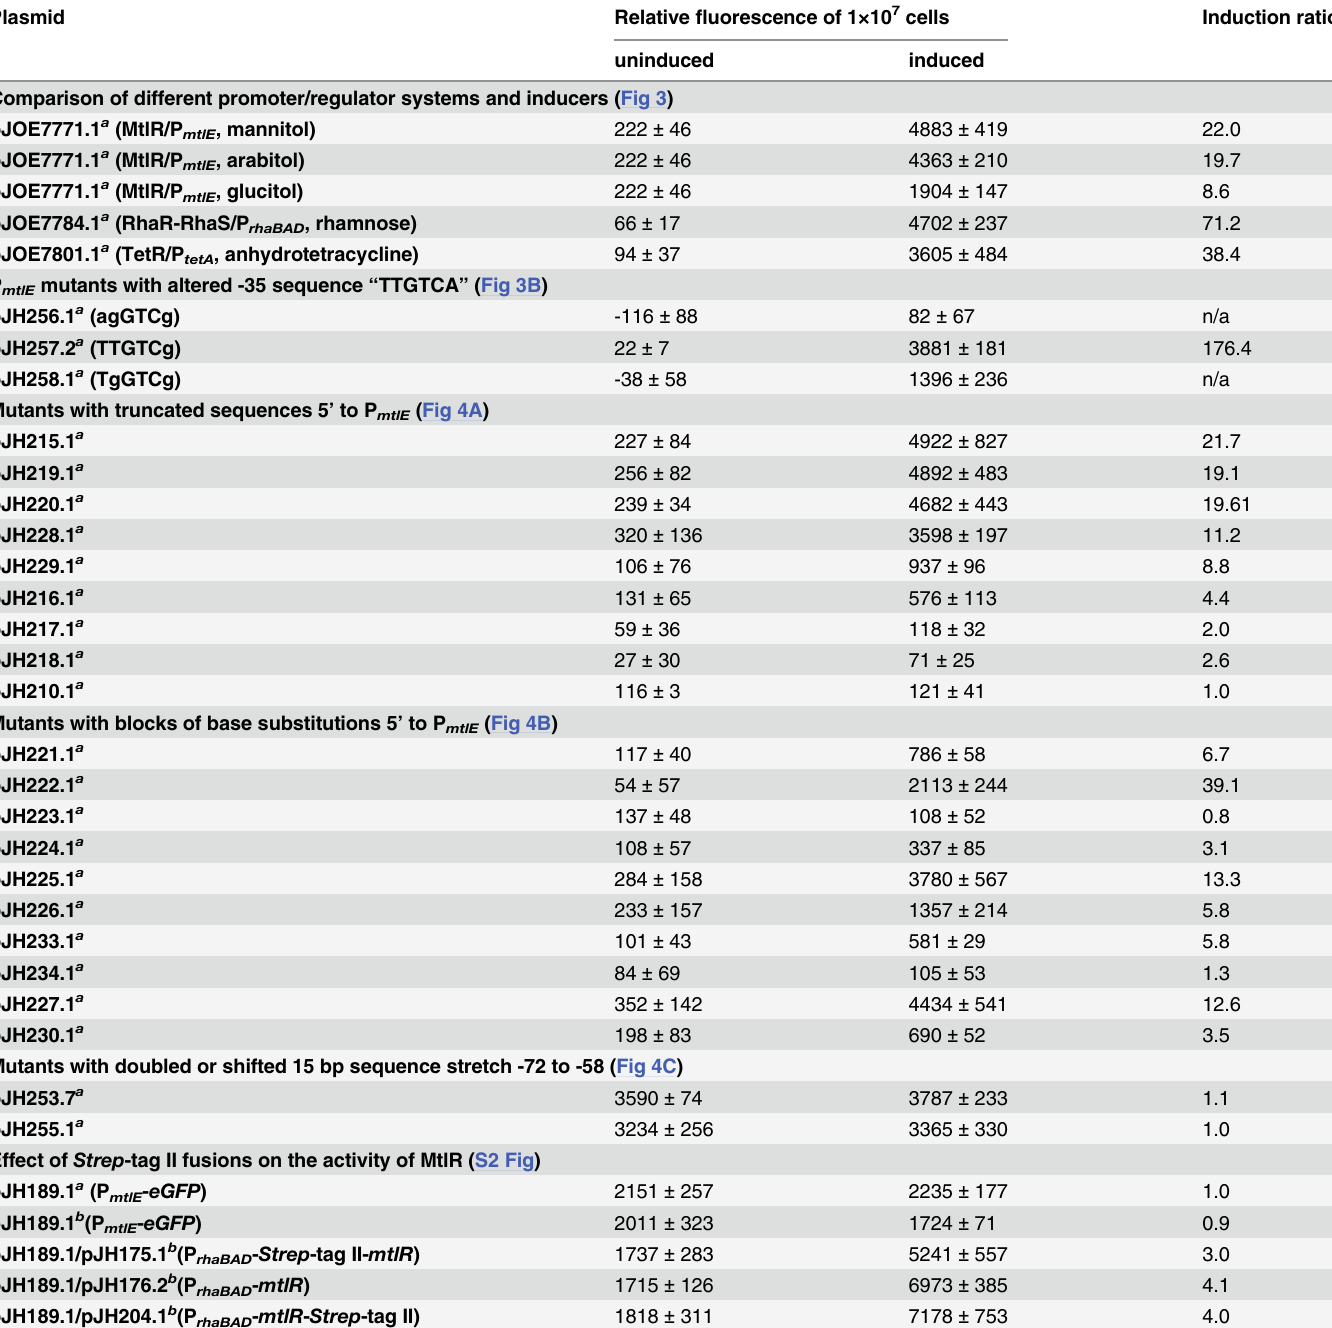
Table 2. Relative fluorescence of plasmid-carrying E . coli HB101 or P . putida GN146 strains measured 6 h after inducer addition. Unless stated oth- erwise, cultures were induced with mannitol.